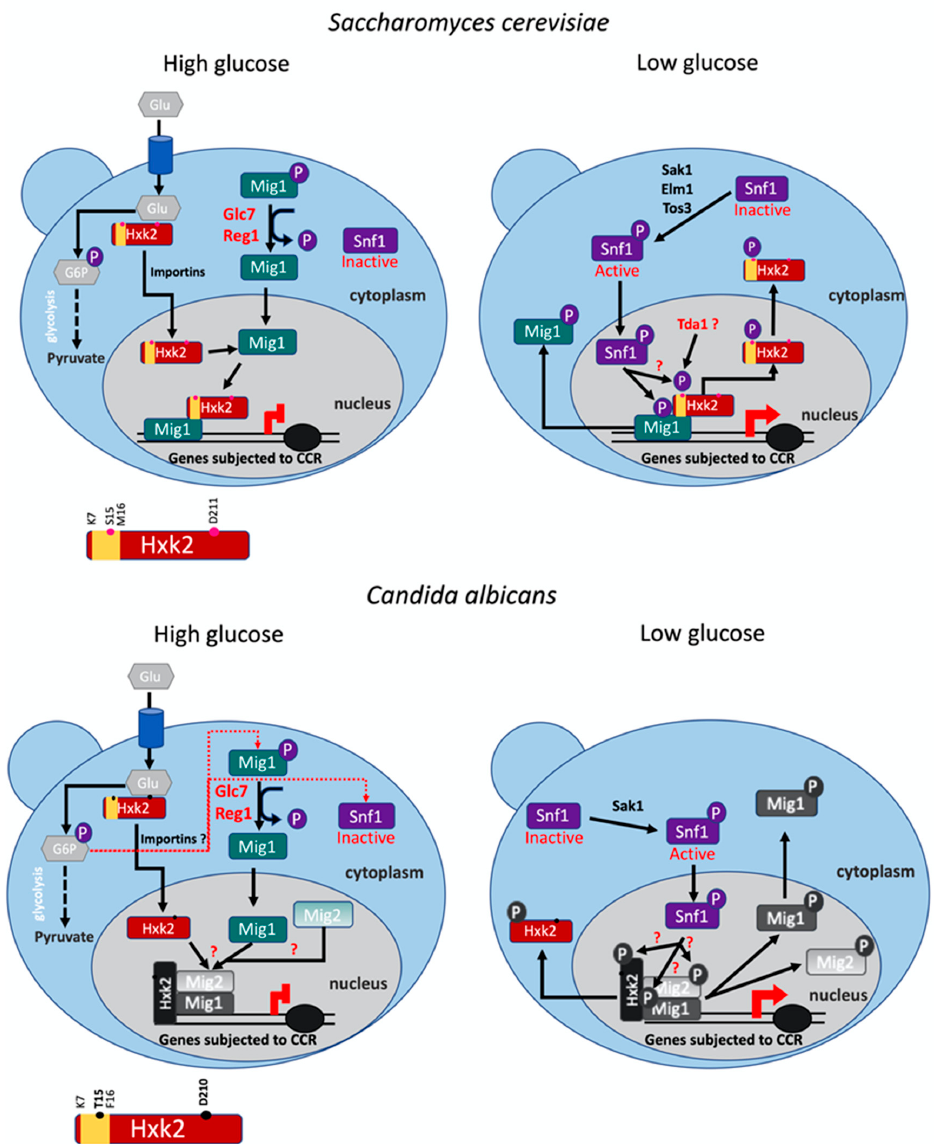
Figure 7. Schematic representation of the main elements implicated in the hexokinase2 (Hxk2) moonlighting functions in C. albicans and S. cerevisiae. Hxk2 is represented by a red rectangle. Point mutations realized in the C. albicans sequence (this study) are indicated by black spots (D 210 , T 15 ) and by red spots in the S. cerevisiae sequence. The N -terminal deleted region from K 7 to F 16 in C. albicans (this study) and from K 7 to M 16 in S. cerevisiae is delimited in yellow. According to the S. cerevisiae model, under high glucose conditions, Hxk2 shuttles from cytoplasm to the nucleus via importins, where it stabilizes the repressor complex, preventing Mig1 phosphorylation by Snf1. The N -terminal decapeptide K 7 to M 16 is necessary for nuclear import and interaction with Mig1. Therefore, expression of genes subjected to carbon catabolite repression (CCR) is repressed. When glucose is low, Snf1 becomes activated and phosphorylates Mig1, which becomes inactivated and leaves the nucleus. Hxk2 is phosphorylated at S 15 and exported to the cytosol. Targeted genes are then expressed. In C. albicans , under high glucose condtions, Hxk2 joins the nucleus. C. albicans D 210 , implicated in glucose binding and phosphorylation, is necessary for carbon catabolite repression. The N -terminal decapeptide K 7 M 16 and residue S 15 are not involved glucose repression in C. albicans . The interaction between Hxk2, Mig1 and/or Mig2 has not yet been demonstrated, but their respective contribution to glucose repression has been shown. At low glucose conditions, Snf1 is activated by Sak1. The nuclear localization of Snf1 and its interaction with the repressor complex have not yet been shown. Localization of elements that are indicated in grey or black has not yet been demonstrated. Interactions that are deduced from the model S. cerevisiae but have not been shown in C. albicans are indicated by red question marks. Red dotted lines indicate the coupling between enzymatic and regulatory